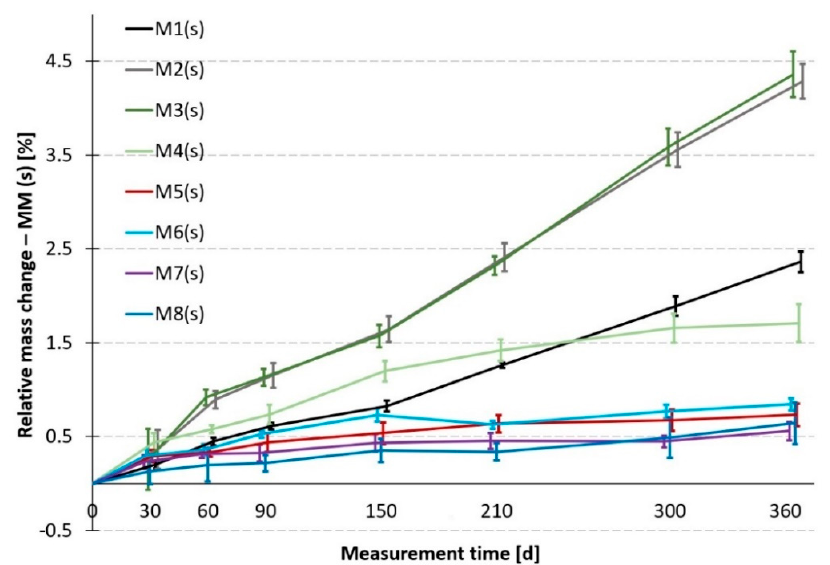
Figure 9. Dependence of the relative mass change on the immersion time of the samples in the sulfate bath.